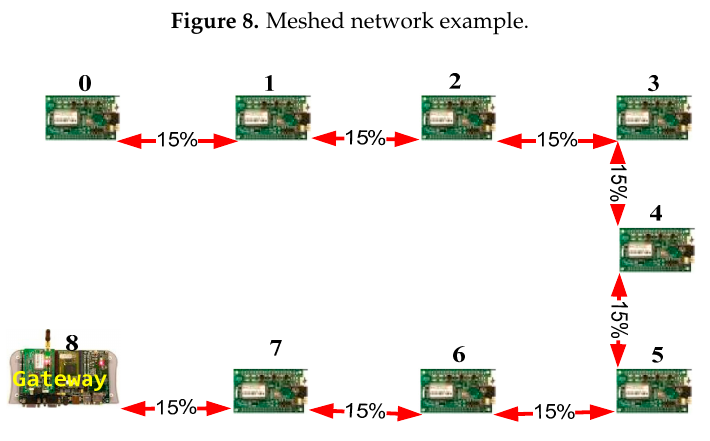
Figure 9. Linear network model example.